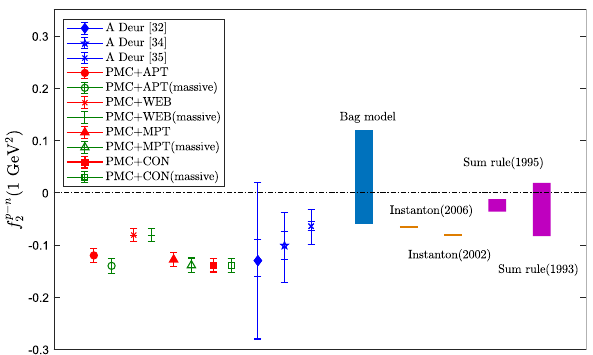
− n ( 1 GeV 2 ) obtained from the PMC Fig. 3 The twist-4 coefficient f p 2 predictions under four α s low-energy models, in which the predictions using JLab data [32,34,35], the QCD sum rule predictions [95,96], and the predictions using the model of the instanton-based QCD vacuum [98,99] and the Bag model prediction [76] are also presented